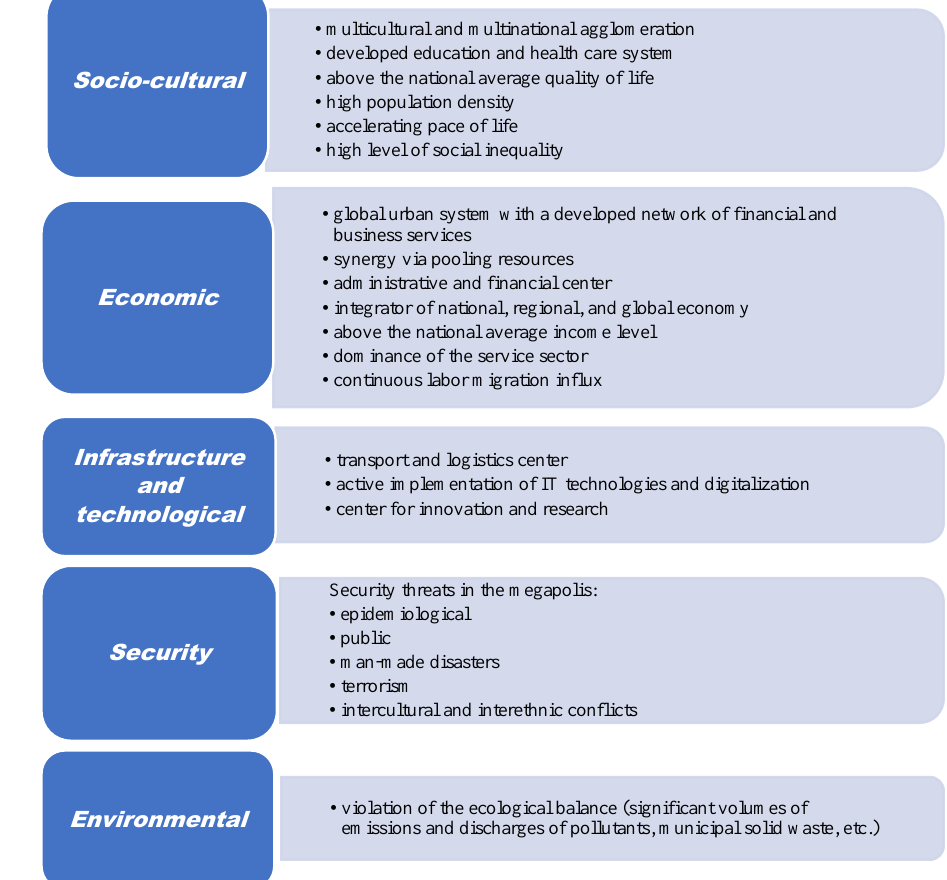
Figure 1. Characteristics of a modern megapolis. Source: Own elaboration.